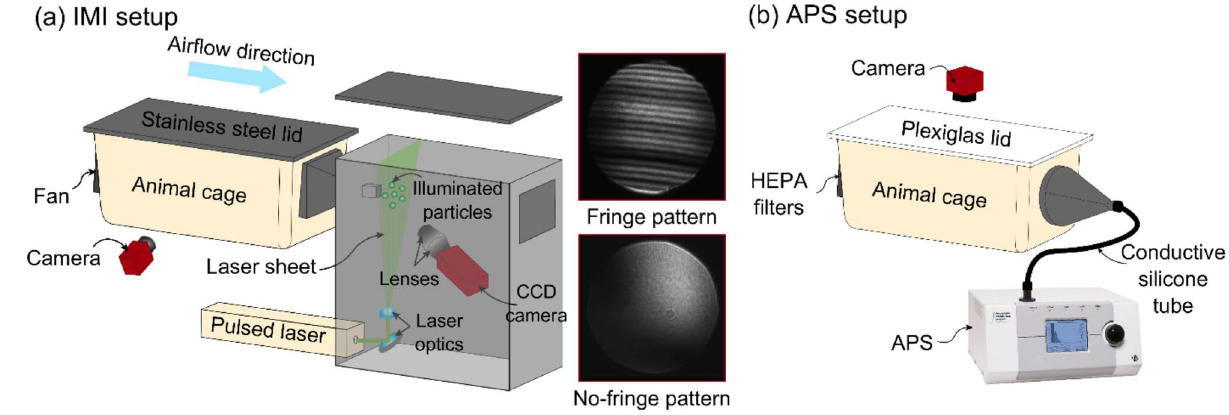
Figure 1. Schematic of interferometric Mie imaging (IMI) and aerodynamic particle sizer (APS) setup. ( a ) IMI setup for counting and qualitatively characterizing particles emitted from a guinea pig cage. Particles emitted from the cage are carried toward the laser sheet by a horizontal airflow. A CCD camera captures out-of-focus images of the illuminated particles; images at right show representative water droplets with diameter of > 2 µm (fringe pattern), and < 2 µm (no-fringe pattern). A second camera captures the time-lapse images of guinea pig in the cage (side-view). ( b ) APS setup for measuring the size distribution of particles with diameter of